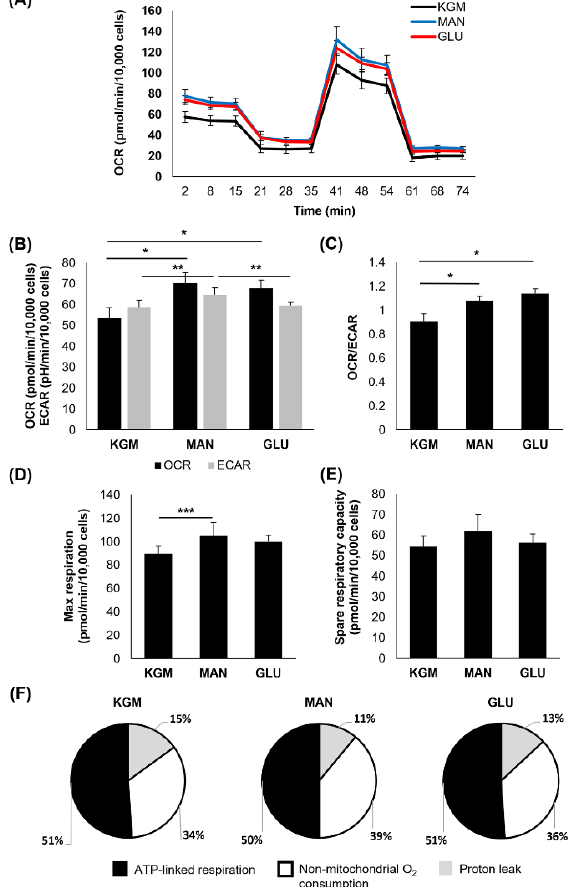
Figure 1. Acute osmotic stress, not hyperglycemia, increases oxygen consumption in corneal epithelial cells. ( A ) OCR plotted as a function of time for both test and control groups. ( B ) OCR was increased in cells treated with 25 mM glucose and 25 mM mannitol compared to the KGM control (* p < 0.001). ECAR was increased in cells cultured in mannitol (** p = 0.007). ( C ) The OCR/ECAR ratio was increased in glucose- and mannitol-treated cells (* p < 0.001). ( D ) Maximal respiration was increased in mannitol-treated cells (*** p = 0.016). ( E ) There were no differences in spare respiratory capacity in glucose- or mannitol-treated cells ( p = 0.129). ( F ) The proportion of oxygen consumption due to ATP-linked respiration, non-mitochondrial oxygen consumption, and the proton leak in the KGM control compared to glucose- and mannitol-treated cells. Bar graphs are presented as mean ± standard deviation. Pie charts are presented as percentage of total oxygen consumption. Graphs are representative of one experiment that was repeated three independent times. One-way ANOVA on ranks with Tukey post hoc comparison test (non-mitochondrial oxygen consumption) and one-way ANOVA with SNK multiple comparison test for all others.